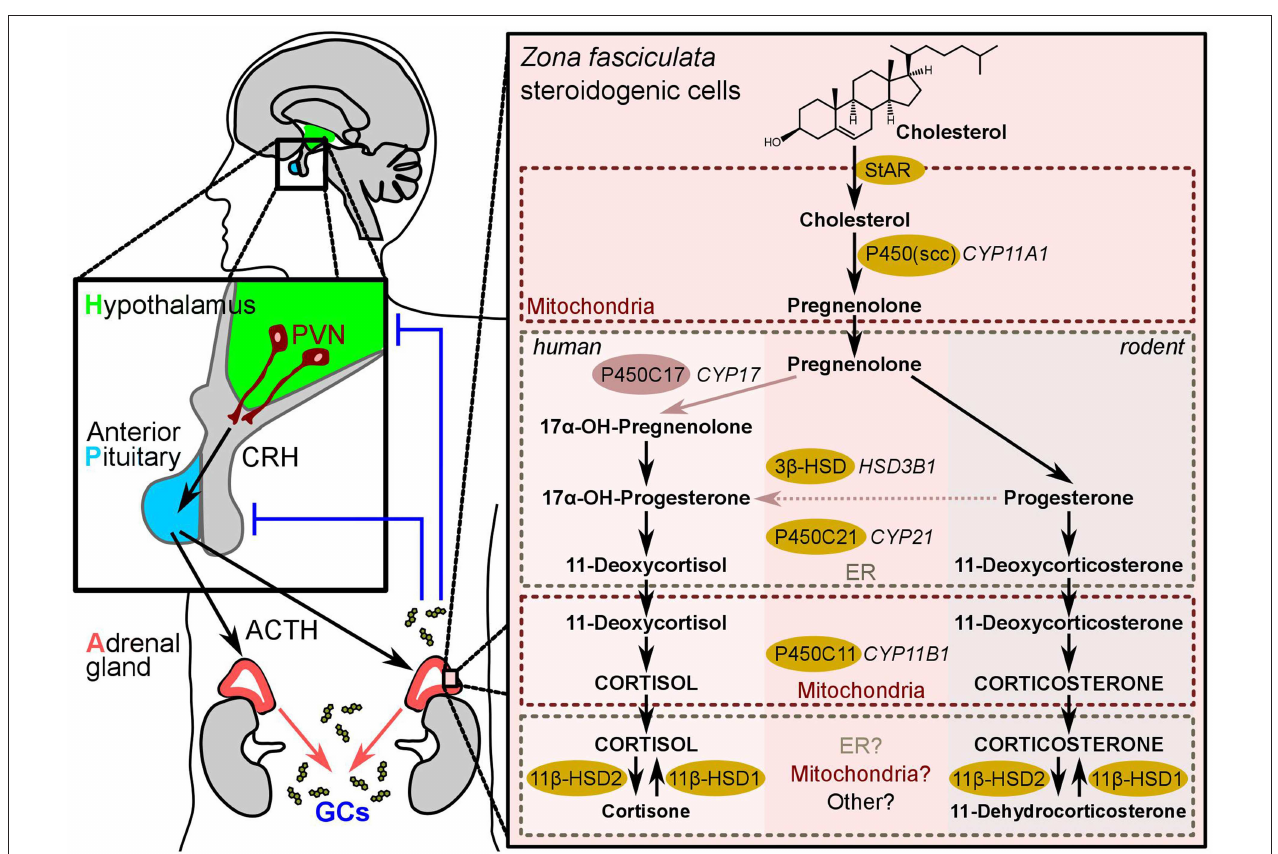
FIGURE 1 | The HPA-axis and adrenal glucocorticoid synthesis. The Hypothalamus-pituitary-adrenal-axis (also known as “stress axis”) represents the sequence of endocrine events between the hypothalamus (green), the anterior pituitary gland (blue), and the cortex of the adrenal gland (red). Corticotropin-releasing hormone (CRH) secreted from the paraventricular neurons (PVNs) of the hypothalamus stimulates adrenocorticotropic hormone (ACTH, corticotropin) release from the anterior pituitary, which consequently stimulates the production of glucocorticoids in the steroidogenic cells of the zona fasciculata in the adrenal cortex. Blue lines indicate negative feedback. The right-hand panel shows the biochemical reactions leading to glucocorticoid-synthesis in humans and in rodents. The synthesizing enzymes are shown in yellow (and light-red for the human CYP17). The (so far known) subcellular localization of the steroidogenic enzymes in the mitochondria or the ER is highlighted by dotted-line